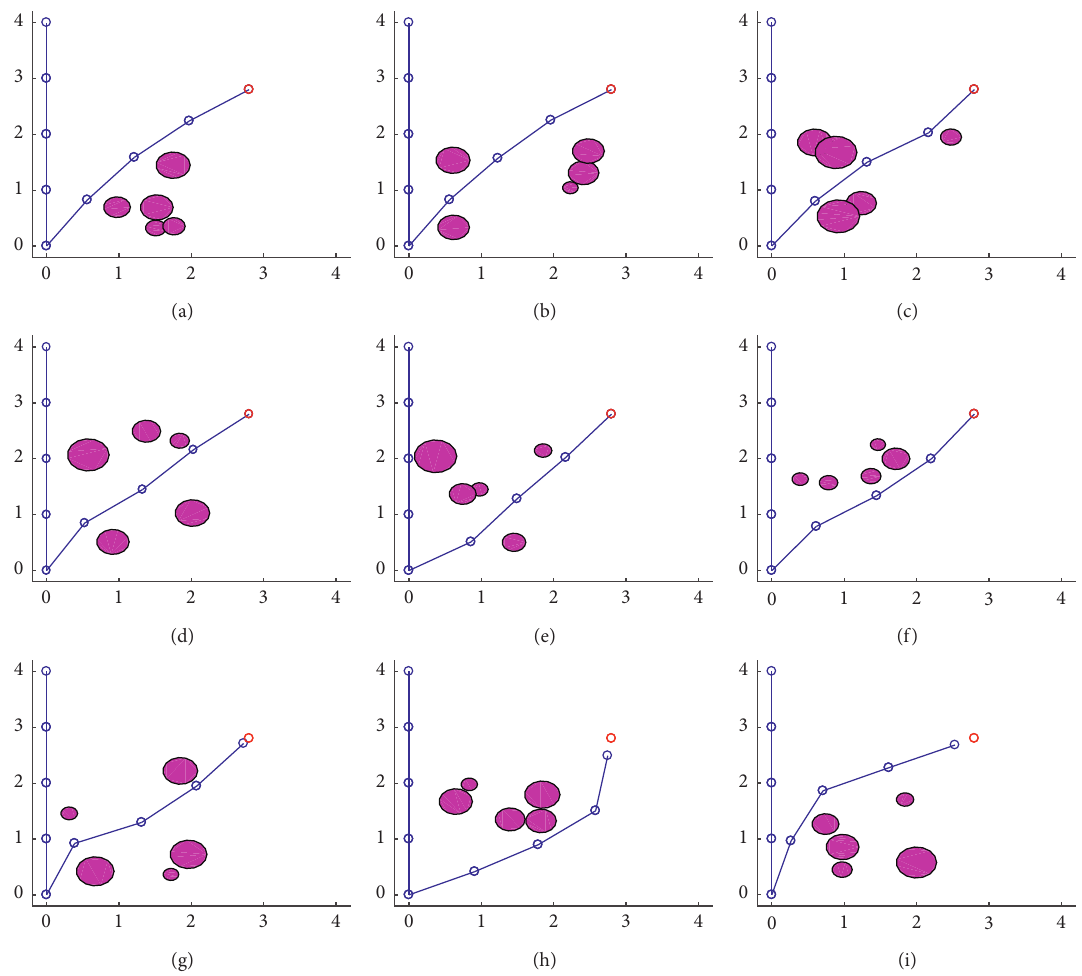
Figure 3: Visualization experiment results of extending FABRIK with obstacle avoidance in test